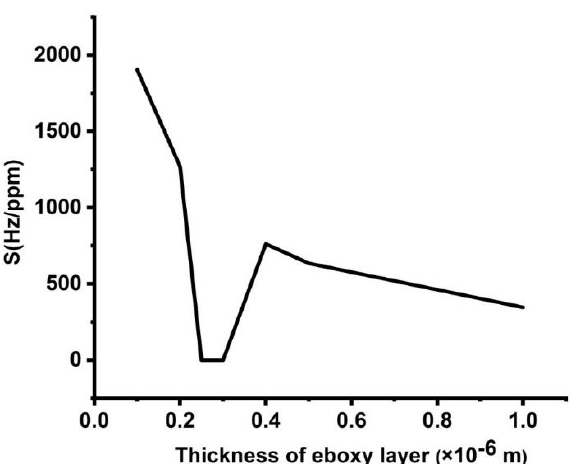
Figure 6. Sensitivity of the designed sensor at different thicknesses of the epoxy layer.